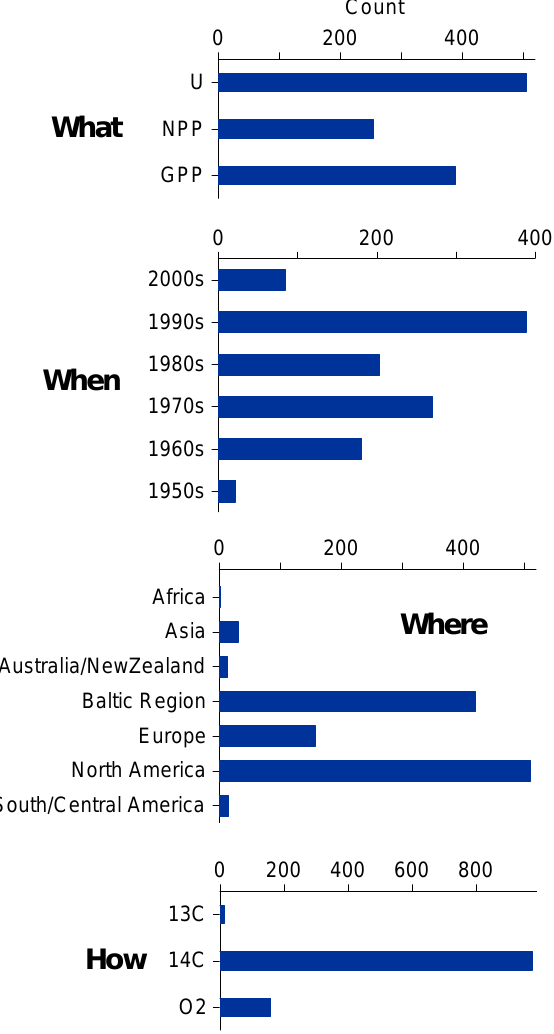
Fig. 1. Summary statistics of 1148 measurements of annual phytoplankton primary production (APPP) in estuarine-coastal ecosystems. Top panel shows what was reported: U = unspecified; NPP = net primary production; GPP = gross primary production. Panels below show the distribution of measurements by decade, re- gion, and method. Median APPP and data sources for each of 131 ecosystems are given in the Supplement Table